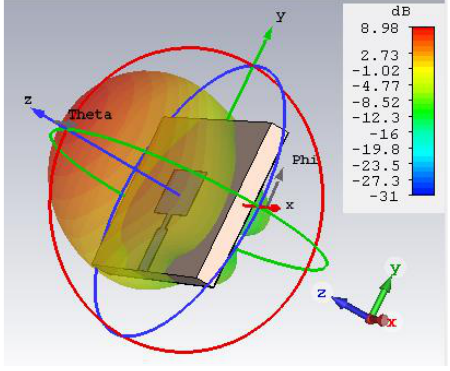
Figure 6. 3D radiation pattern of the proposed antenna . Table 1. The proposed antenna parameters .